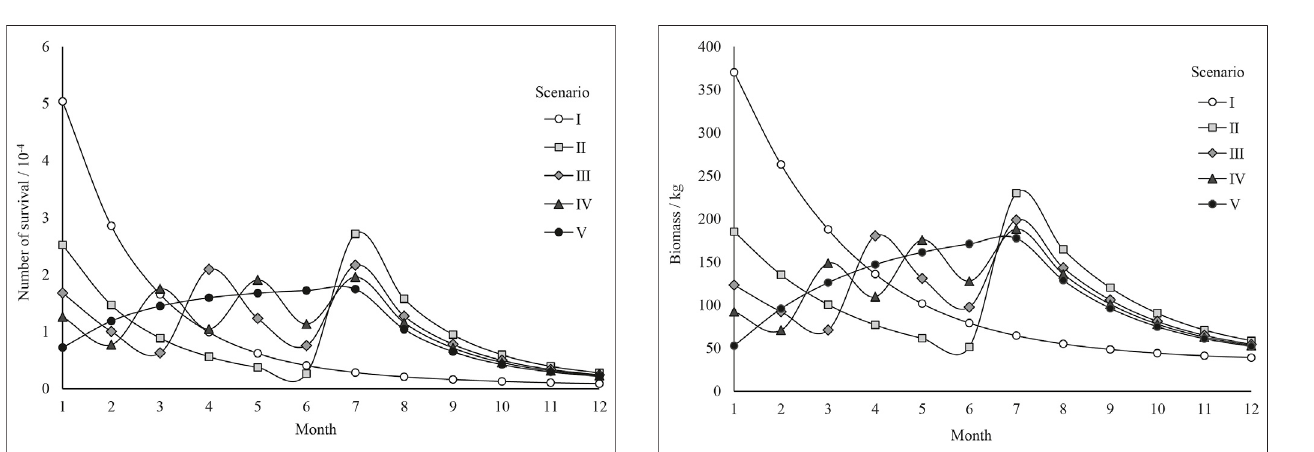
FIGURE 6 | Changes in the biomass of survived fi sh under scenarios. Scenario I to V indicated that the total number of fi sh were released in one, two, three, four, and seven events, respectively, with different intervals during 6 months.